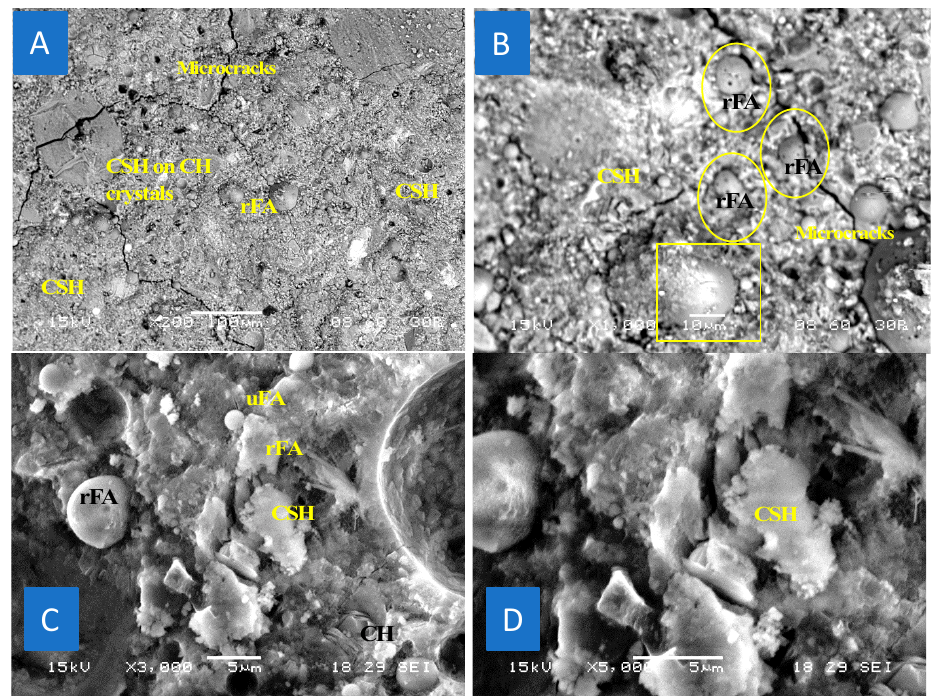
Figure 23. BSC micrograph of PC55LS20FA20+5% μ S at 28D at ( A ) 200× magnification, ( B ) 1000× magnification, ( C ) 3000× magnification and ( D ) 5000× magnification.